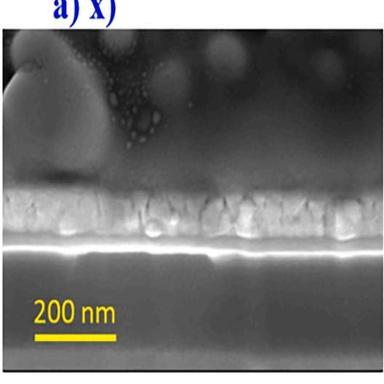
s) surface and x) cross-section SEM images obtained at 30 kV with 50 k magnification of BZT thin films deposited at: a) 350º C, 60 min; then b) annealed at 550º C, 60 min in O2. Deposited at c) 550º C, 50 min with O2:Ar.= 50%.